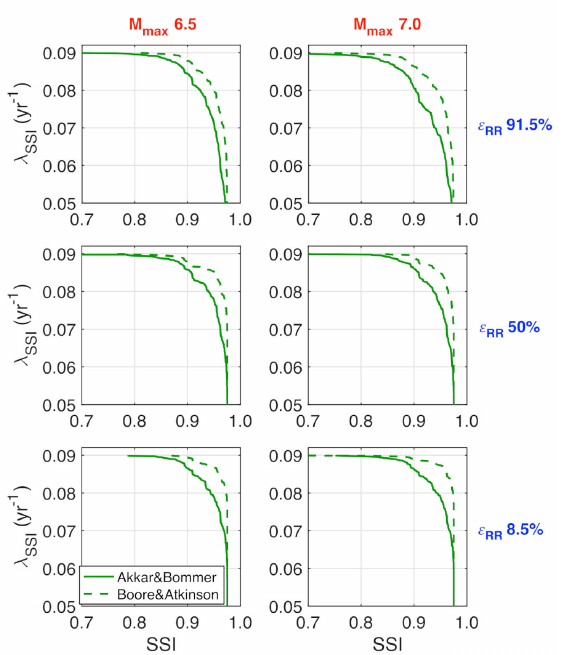
Figure 7. Mean annual frequency (MAF) curves of System Serviceability Index (SSI), due to di ff erent choices of ground motion prediction equation (GMPE), M max and residuals in the gas network (GAS) fragility model.